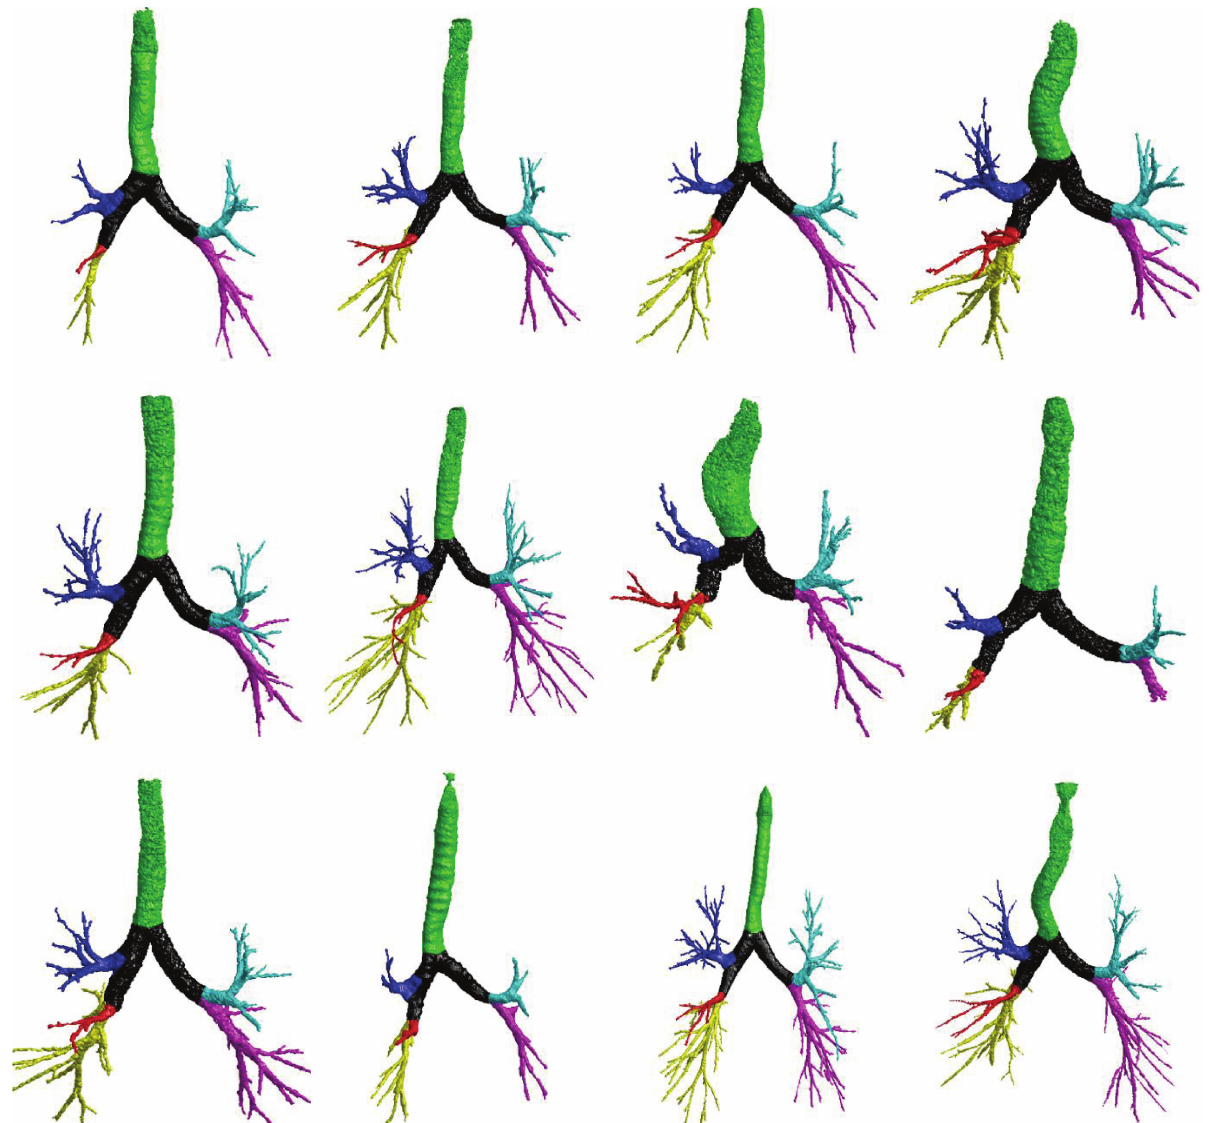
Figure 7: Examples of the airway labeling